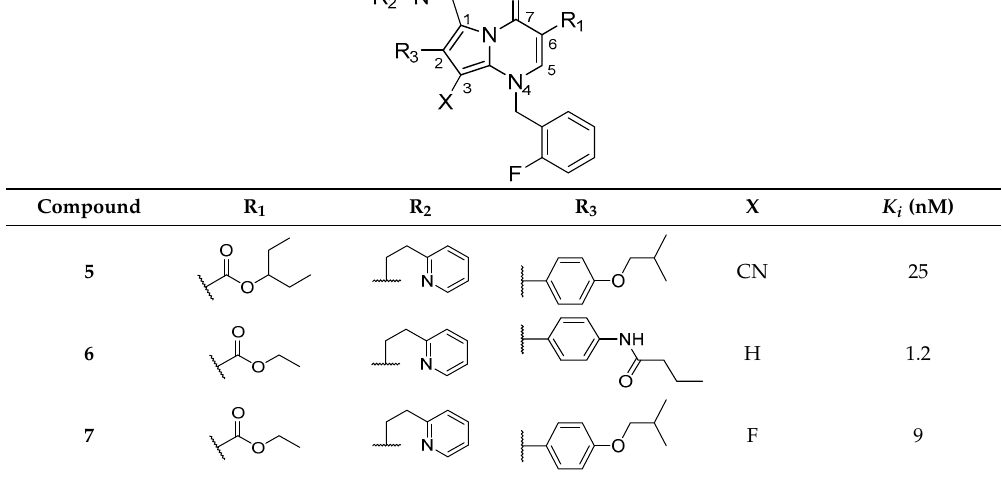
Compound Compound